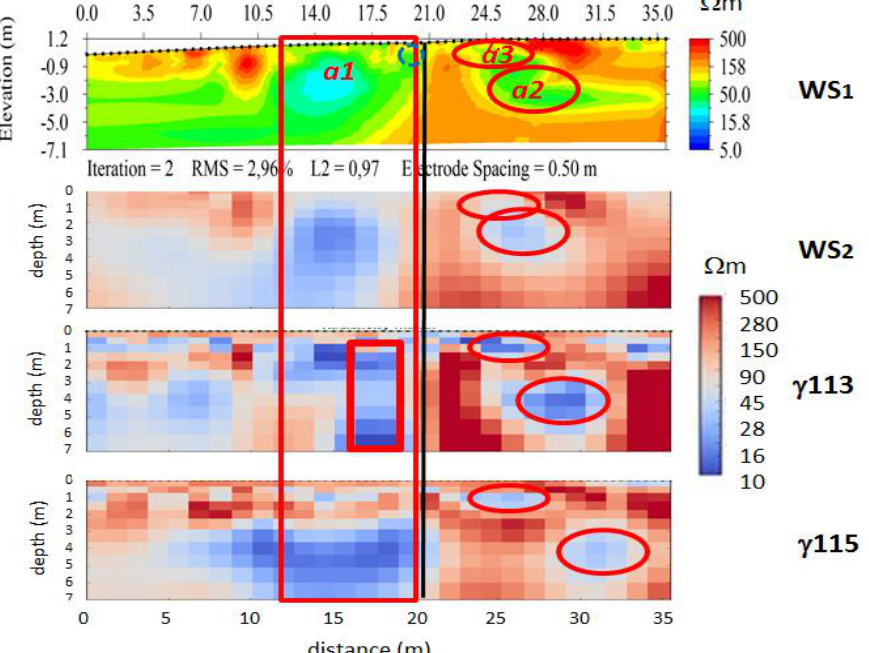
Figure 8. Electrical resistivity tomography reconstruction of water-bearing zones (red rectangles and ellipses) using different geoelectric methods (Section 3.1.2). The WS1 profile is taken from [41].